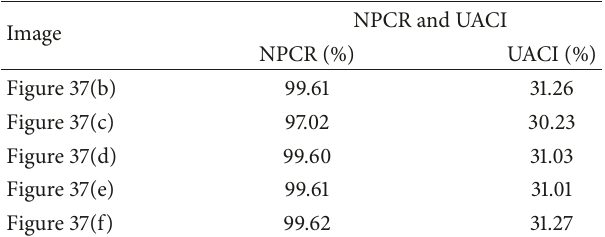
Table 6: NPCR and UACI between Figures 37(a) and 37(b)–37(f).